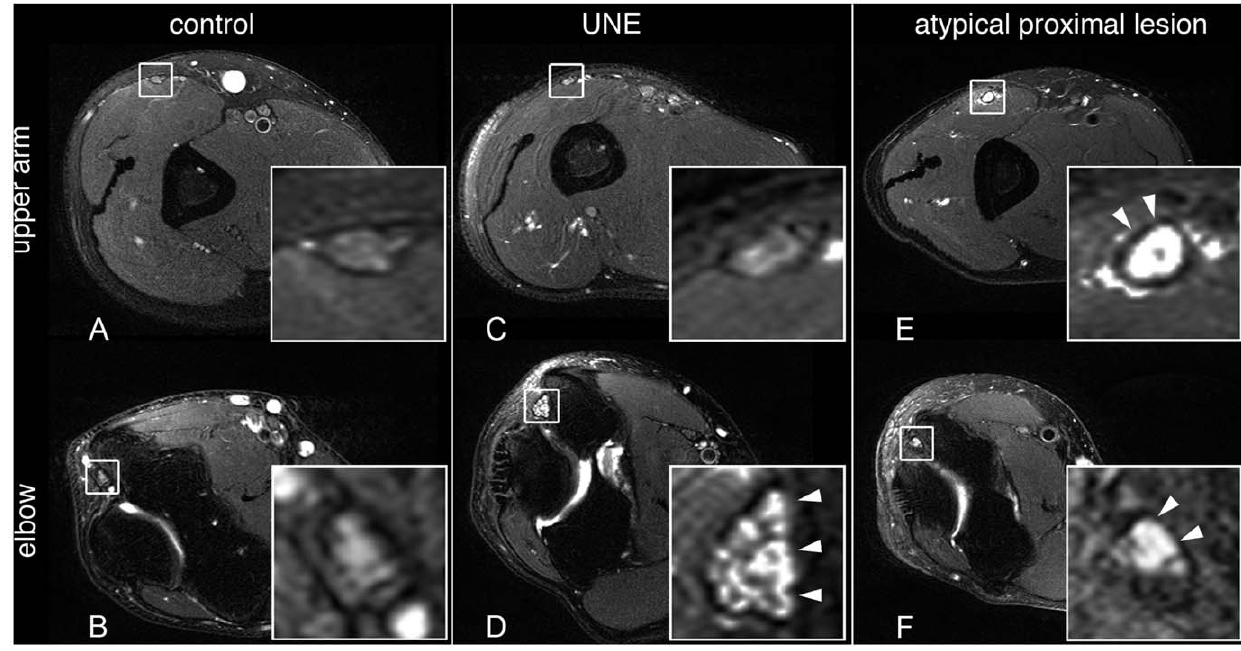
Figure 1. Typical imaging findings in healthy control, UNE and proximal ulnar nerve lesion. Upper row shows T2-w cross sections through upper arm, lower row through elbow. The first column [A and B] represents a healthy control with only slight ulnar nerve signal increase at the elbow. The second column is a typical UNE with inconspicuous ulnar nerve at upper arm level [C] and clear increase of signal and cross-sectional area at the elbow [D] (arrowheads). The third column shows a patient with atypical proximal lesion at upper arm level [E] as well as the elbow [F].